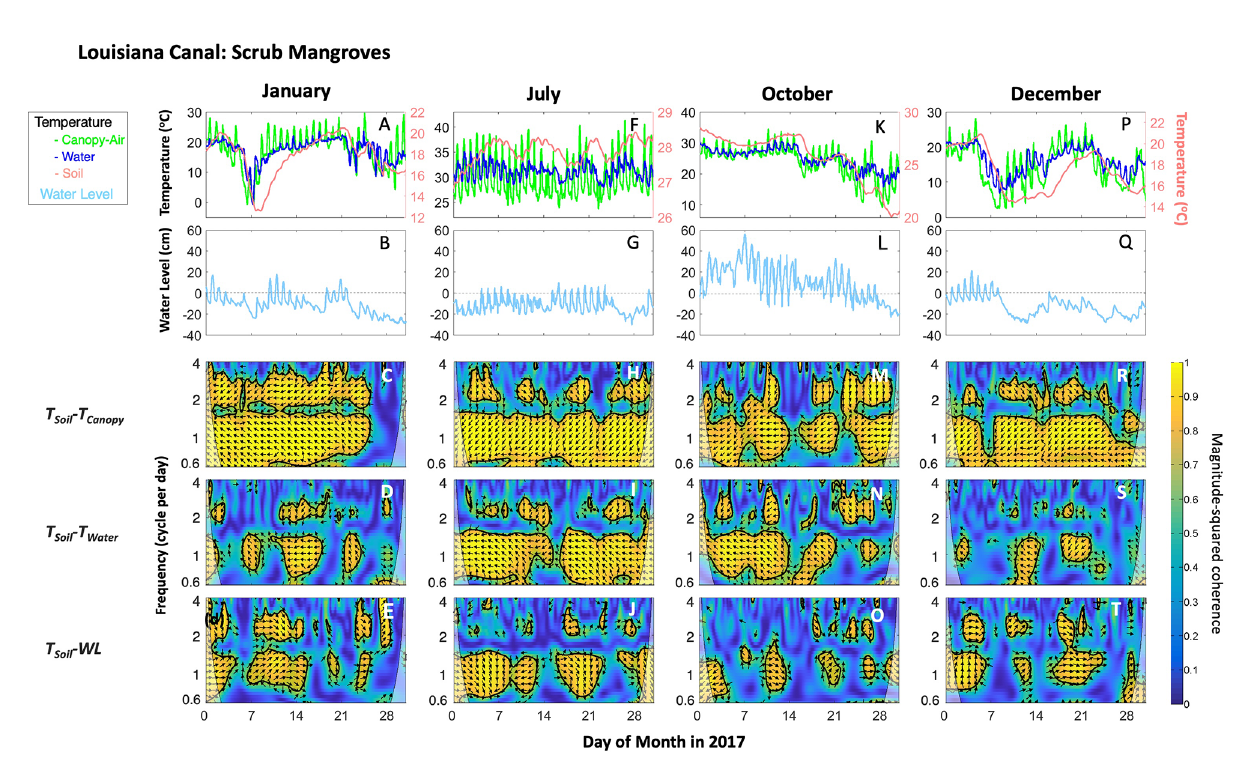
FIGURE 7 | Temperatures in three mediums (row 1: A, F, K, P ; i.e., Canopy air: T Canopy , Soil: T Soil , and Water: T Water ), water level (WL; row 2: B, G, L, Q ), and wavelet plots (rows 3 − 5; frequency in cycle per day or cpd) for scrub mangroves in the Canal site in Port Fourchon, Louisiana during 2017. Selected months represent different seasons. The wavelet coherence values are displayed for paired T Soil -T Canopy (C, H, M, R) ; T Soil -T Water (D, I, N, S) and T Soil -WL (E, J, O, T) . The colored wavelet panels (blue to yellow tones) show the wavelet magnitude-squared coherence. The arrow direction indicates the phase difference between the pair of variables: a right direction indicates that the variables are in phase while a left direction indicates that the variables are out of phase. Yellow areas bounded by thick black lines indicate signi fi cant coherence at the 95% level. Notice that the soil temperature (row 1) is shown in red color along the right-side y-axis